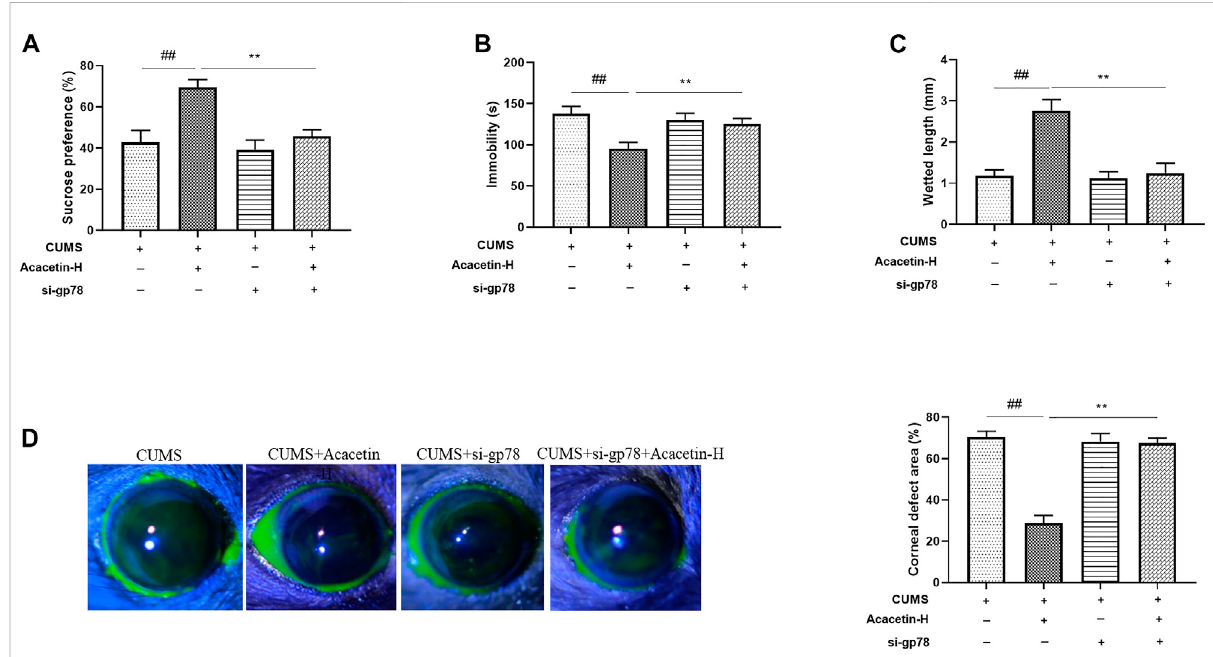
FIGURE 9 Impactofgp78siRNAsondepressivebehaviorsanddryeyesymptomsinCUMSmice. (A) Sucrosepreferencepercentageofmiceinthesucrose preference test. (B) Immobilitytime ofmiceinthetailsuspensiontest. (C) Tearvolumesofmiceweremeasuredusingcottonphenolredthreads. (D) Determination of corneal epithelial defects by fl uorescein staining in CUMS mice. Results are expressed as the mean ± SEM ( n = 9 per